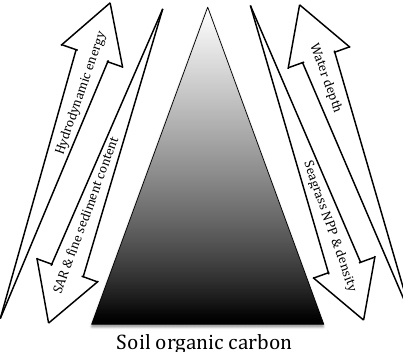
Figure 6. Influence of biogeochemical factors on the organic carbon storage capacity of seagrass ecosystems. Organic carbon in seagrass soil increases with high SAR, fine sediment content, seagrass NPP and density; and decreases with high hydrodynamic energy and wa- ter depth. SARs, soil accumulation rates; NPP, net primary produc-